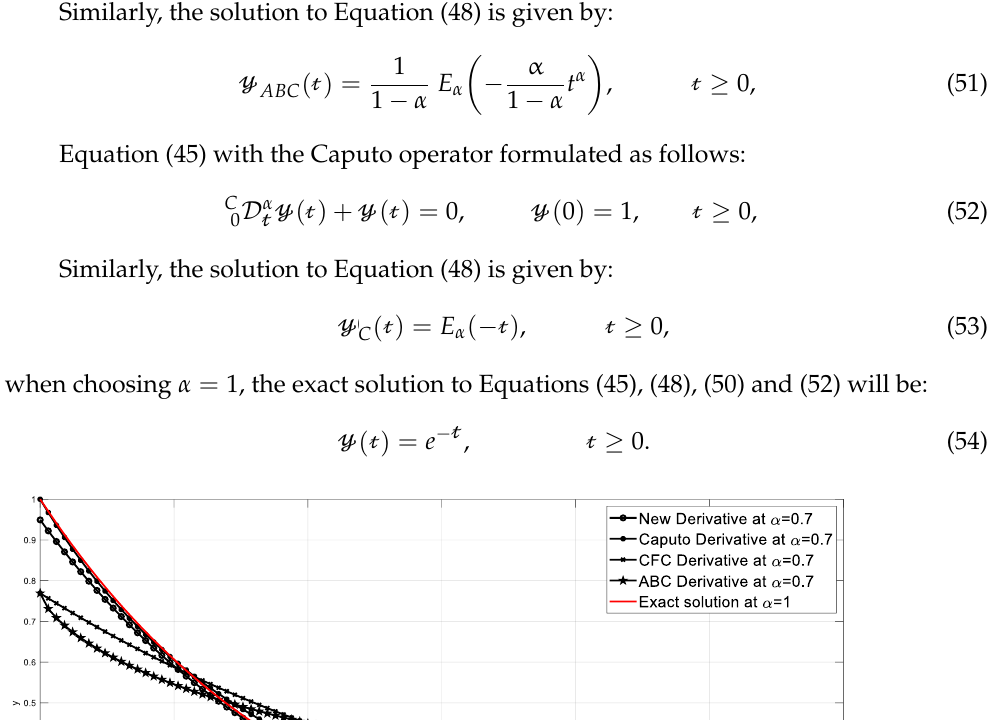
Table 1. The values of the exact solutions at 𝛼 = 0.9 and absolute error of Equations (45), (48), (50), (52) and (54) at different values of 𝓉 .